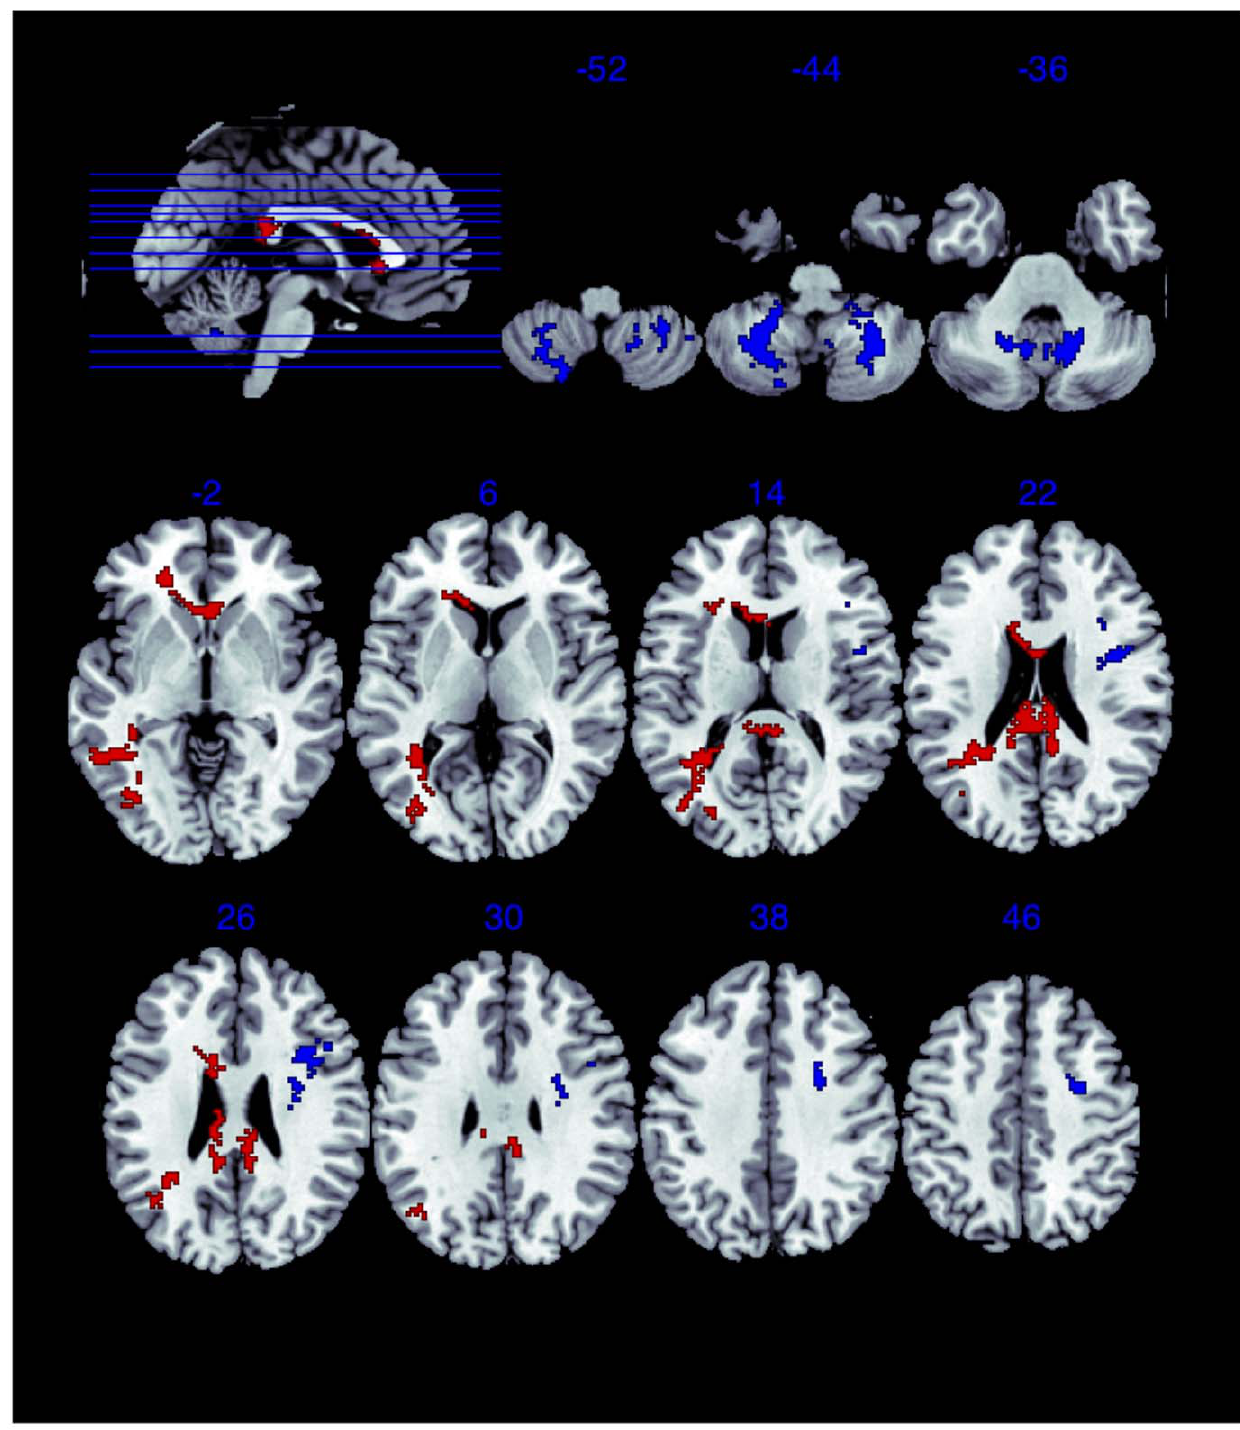
Figure 1. Areas of Gender Difference in Fractional Anisotropy. Red areas represent higher FA in women; Blue areas represent higher FA in men. Numbers Refer to the MNI Z-coordinate of the image below. The Left side of the brain is depicted on the Right side of the images.